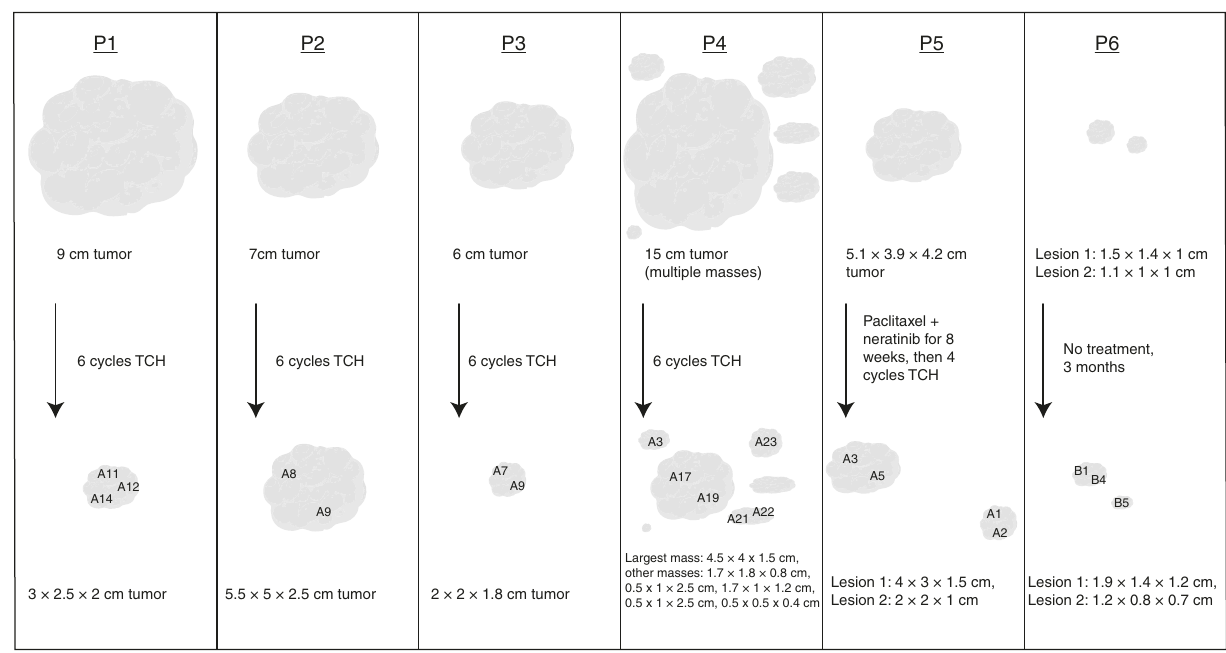
Fig. 2 Longitudinal multi-region HER2-positive breast cancer cohort. Pre-treatment tumor sizes were determined from the medical oncologist ’ s initial measurements. Post-treatment (or in P6, surgical) tumor sizes were determined from the pathologist ’ s report of the surgical specimen. Tumors are drawn to scale and approximate locations of the tumor blocks from which the multi-region samples are shown. TCH docetaxel/carboplatin/trastuzumab. Tumor shapes from